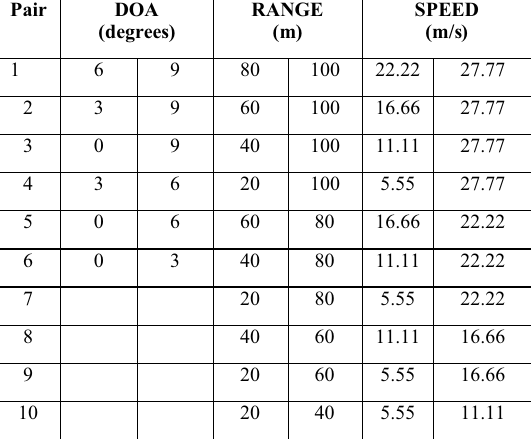
TABLE IV. P AIRS OF RANGES , ANGLES , AND SPEEDS MOTOCYCLE